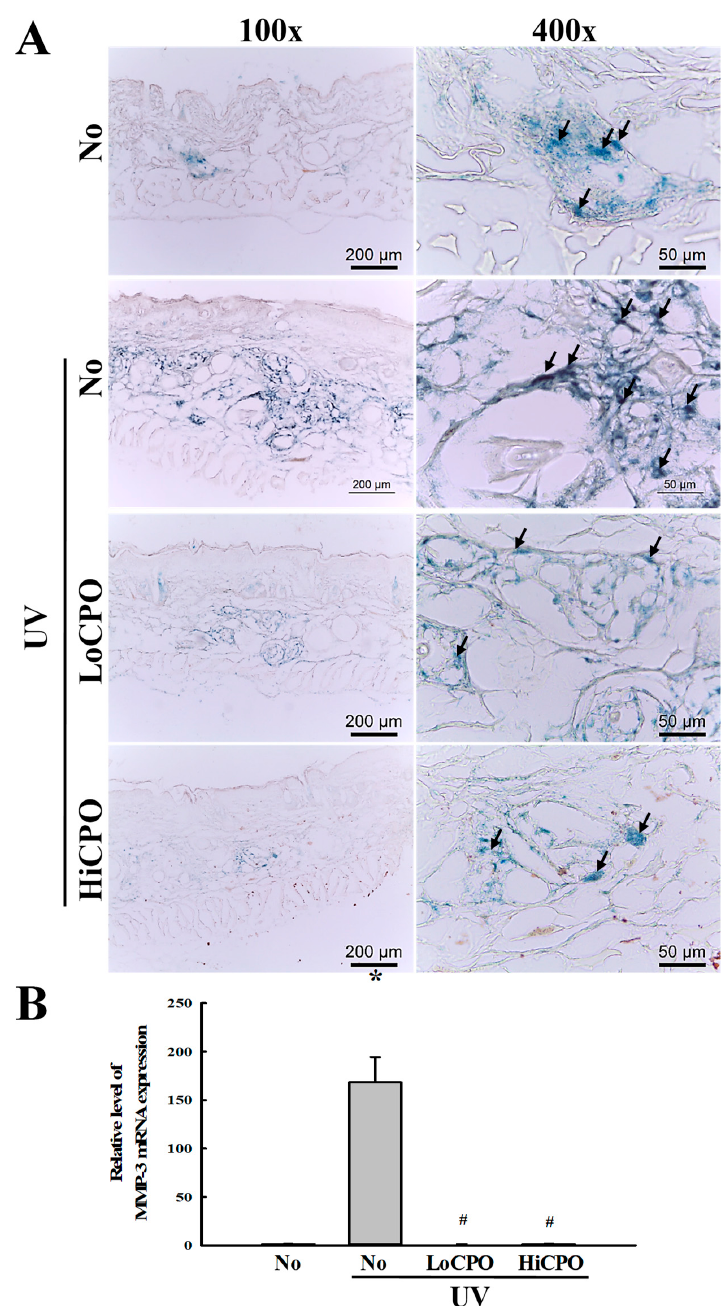
Figure 9. Level of galactosidase and MMP-3 mRNA. ( A ) Galactosidase staining analyses. The morphological features of cells stained with X-gal in dimethylformamide solvent at 37 ◦ C, were observed in skin tissues at 400 × magnification. Three to five mice per group were used and galactosidase levels were determined in duplicate for each mouse. ( B ) Expression level of MMP-3 mRNA. Levels of MMP3 in skin total mRNA were determined by quantitative real-time (qRT)-PCR using specific primers. mRNA levels were calculated with respect to β -actin mRNA (endogenous control). Three to five mice per group were used and PCR was conducted in duplicate. Data are reported as the means ± SD. * p < 0.05 compared to the No group. # p < 0.05 compared to the UV + No group. Abbreviations: LoCPO, low amount CPO; HiCPO, high amount